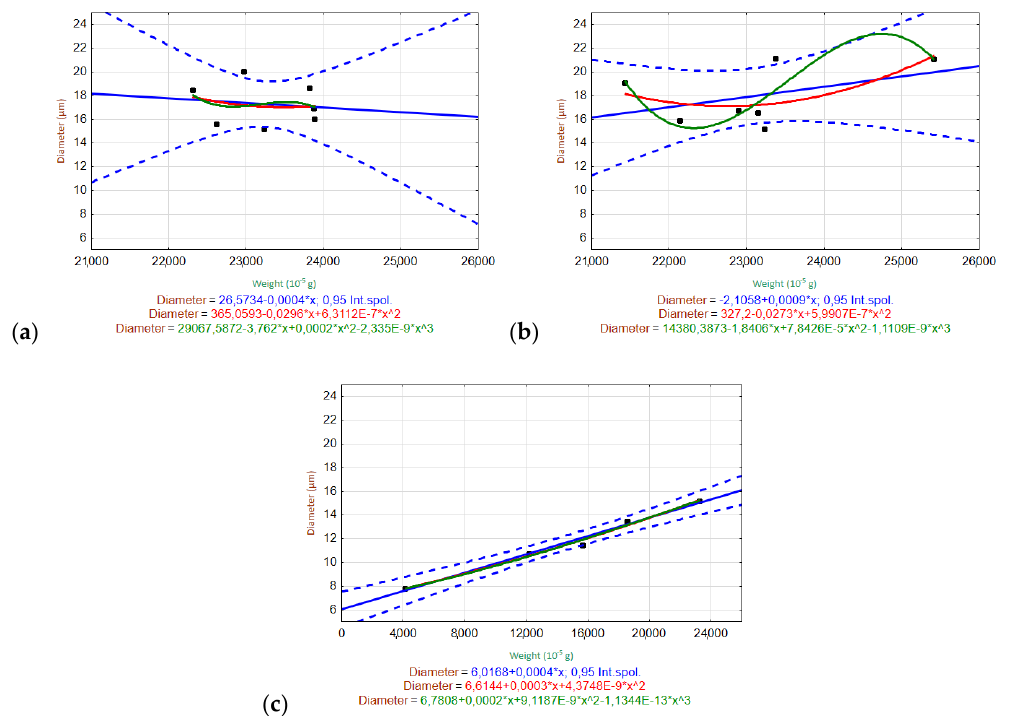
Figure 11. Scatter plots of the relationship between the fiber diameter and weight of EGFs treated with different solutions: ( a ) H 2 O, ( b ) Ca(OH) 2 , and ( c ) K 2 SiO 3